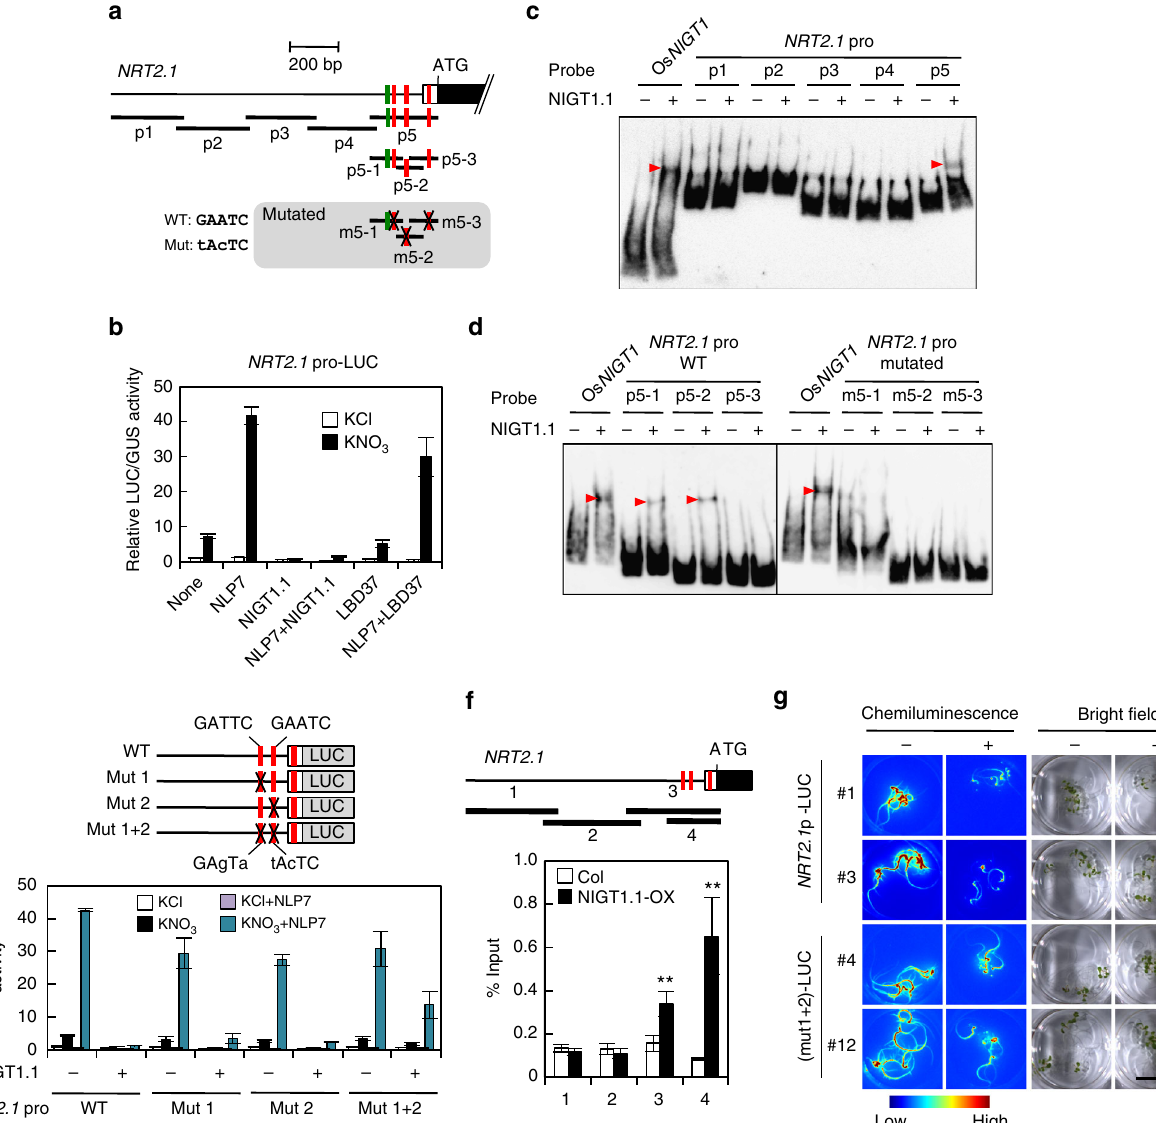
Fig. 1 Repression of the NRT2 . 1 promoter by NIGT1.1. a Structure of the NRT2 . 1 promoter. Consensus sequences for NIGT1 binding (5 ′ -GAATC-3 ′ ) and LBD binding (5 ′ -GCGGCG-3 ′ ) are indicated by red and green bars, respectively. White and black boxes indicate the 5 ′ untranslated and coding regions, respectively. Probe DNAs used in EMSA ( c , d ) are shown below the promoter structure. To disrupt the NIGT1-binding sequences, mutated probes contained nucleotide substitutions, indicated by X. b Activation of the NRT2 . 1 promoter by nitrate and NLP7 and repression by NIGT1.1 in protoplasts. Protoplasts co-transfected with the NLP7, NIGT1.1 or LBD37 expression vector or the empty vector (none) together with the reporter plasmid containing the LUC gene fused to the NRT2 . 1 promoter were incubated in the presence of 1 mM KCl or KNO 3 . In b and e , LUC activity was normalised with GUS activity from the reference UBQ10-GUS plasmid and data are means± s.d. of three biological replicates. c , d EMSA with recombinant NIGT1.1 protein and DNA probes from the NRT2 . 1 promoter. Red arrowheads indicate positions of protein – DNA complexes caused by binding of NIGT1.1 to probe DNA. The Os NIGT1 probe served as a positive control. e Effects of disruption of the NIGT1-binding sites on the NRT2 . 1 promoter activity in protoplasts. Protoplasts co- transfected with the LUC gene fused to the wild-type or mutant NRT2 . 1 promoter and the NLP7 expression vector or an empty vector were incubated in the presence of 1 mM KCl or KNO 3 . X indicates disrupted NIGT1 sites. f ChIP analysis of the NRT2 . 1 promoter using Col and NIGT1.1-OX seedlings. Four regions were ampli fi ed by PCR with immunoprecipitated DNA. Data are means of four biological replicates with s.d. ** p < 0.01 by one-tailed t test. g Effects of disruption of the NIGT1-binding sites on NRT2 . 1 promoter activity in the presence of abundant N. Five seedlings of transgenic lines harbouring the LUC gene fused to the wild-type [ NRT2 . 1p (WT)- LUC ] or the mutated [(mut1 + 2)-LUC] NRT2 . 1 promoter were incubated with ( + ) or without ( − ) 10 mM NH 4 NO 3 for 24 h. Images of LUC activity in vivo and bright- fi eld images were captured in two independent transgenic lines. Bar, 2